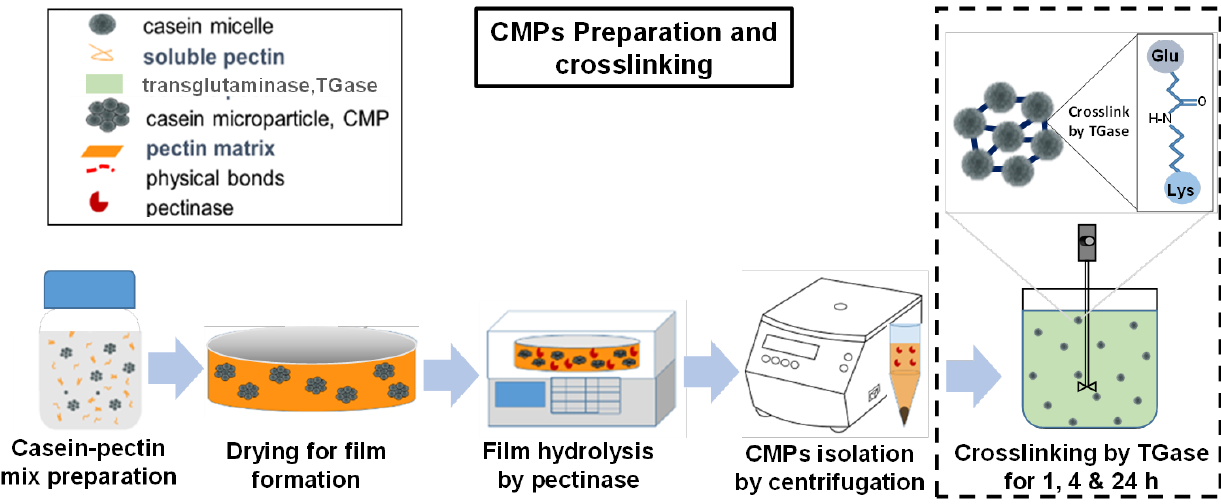
Figure 1. Manufacturing process of CMPs that first leads to aggregates of casein micelles by volume exclusion of the added pectin, which are subsequently solidified by film drying to form CMPs that are then released by degradation of the pectin matrix by pectinase and resolubilized in buffer at pH 6.7. The subsequent cross-linking of the CMPs produced by the enzyme TGase is highlighted.